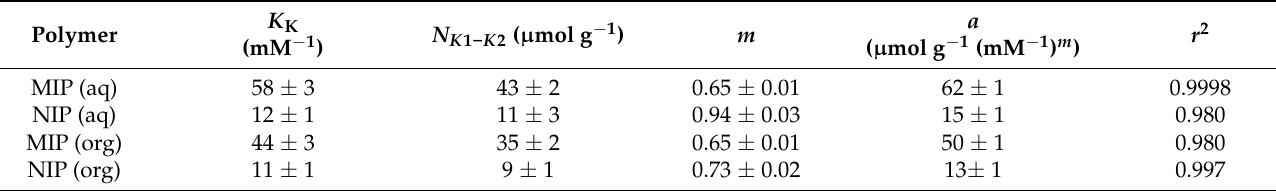
Figure 10. Equilibrium binding isotherms for DYKDDDDK to the mMIP (blue) and to the corre- sponding NIP (cyan), synthesised in aqueous solvent, and the mMIP (red) and to the corresponding NIP (pink), synthesised in organic solvent. The solid lines correspond to the fits to the Freundlich equation (B = aF m ) (10 points, n = 2). Table 5. Equilibrium binding isotherm parameters for the uptake of FLAG-tag (in Tris buffer 20 mM) synthesized by their corresponding MIPs and the NIPs in aqueous and organic solvent. The polymer binding capacity ( a ) and the binding site heterogeneity index ( m ) were obtained from the fit of the experimental data to the corresponding Freundlich isotherm.